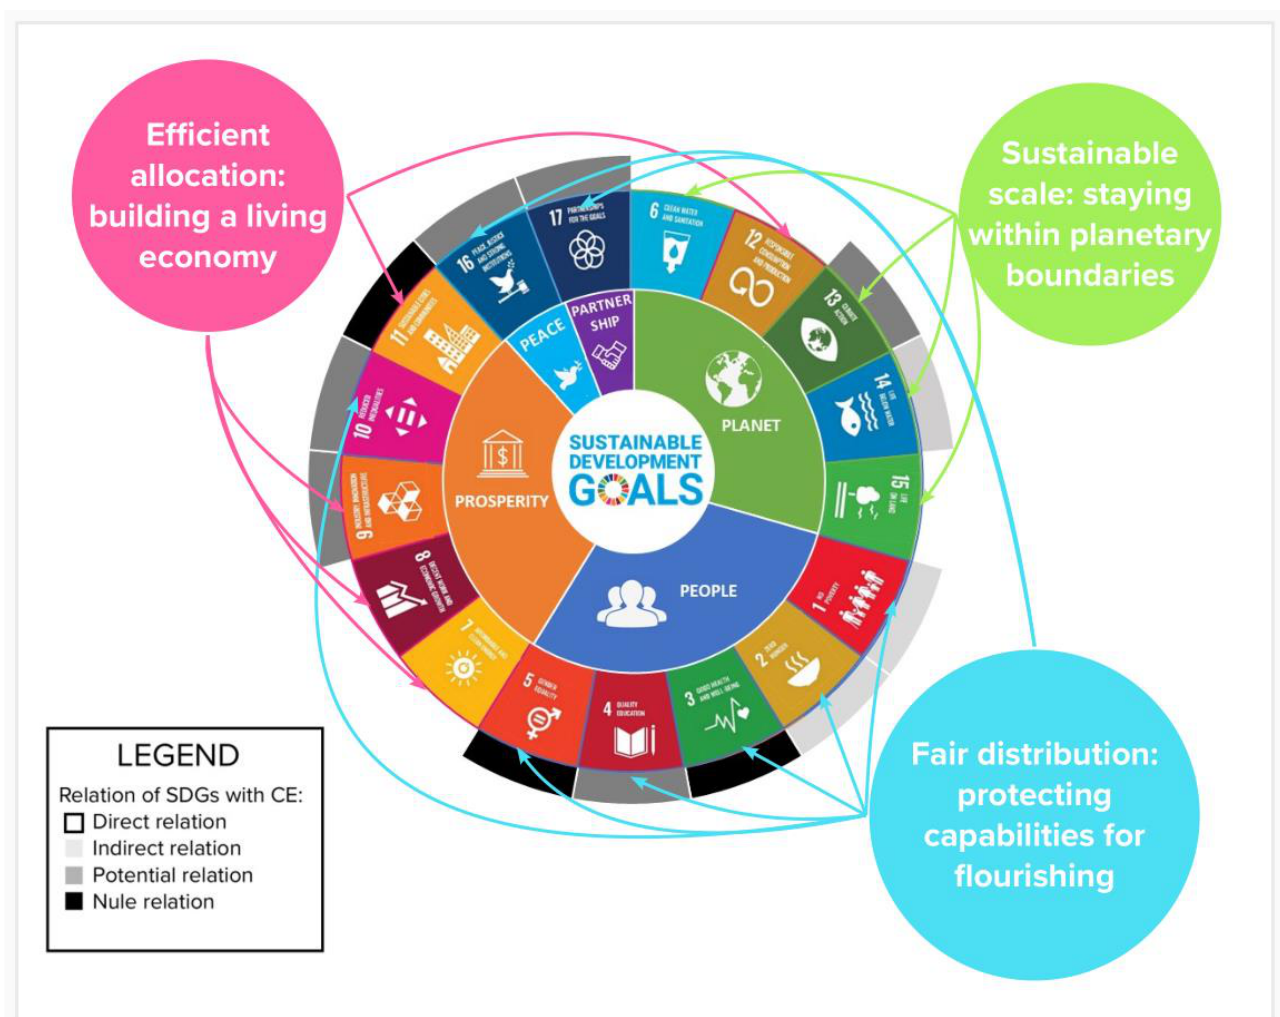
Figure 1. Relation between SDGs and circular economy. Source: our own elaboration adapted on Costanza et al. [7] and Schröder et al.